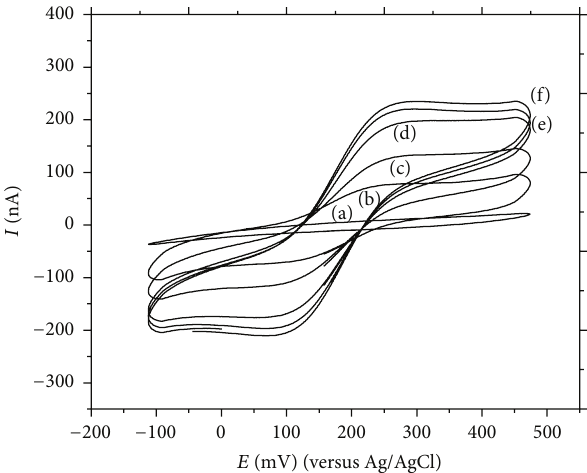
Figure 4: Electrochemical data for FOSC action on s-BLM as a function of preincubation times. Cyclic voltammetric response of 1.0 mmol/L K 3 [Fe(CN) 6 ]/K 4 [Fe(CN) 6 ] (1: 1) solution containing 0.1 mol/L KCl, at Pt electrode s-BLM after interaction with 5.0 g ⋅ L of FOSC for different times: (a) 0min, (b) 5min, (c) 10min, (d) 15min, (e) 30 min, and (f) 50 min. Scan rate 50mV ⋅ s −1